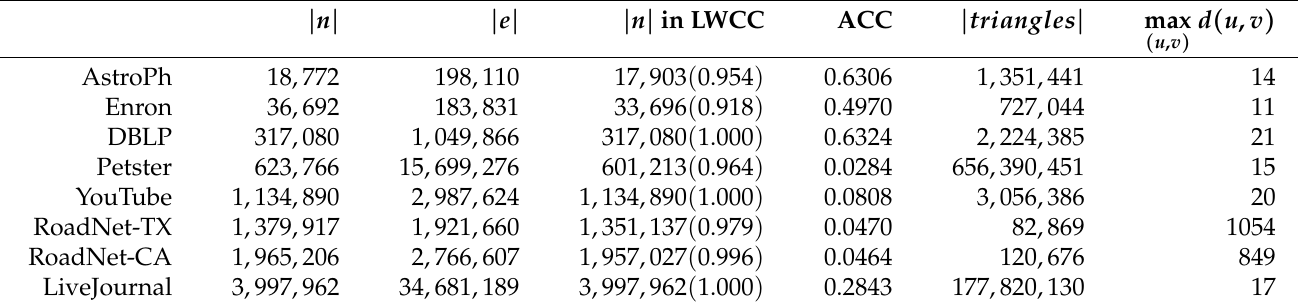
Table 3. Real–world network datasets used in our experiments.